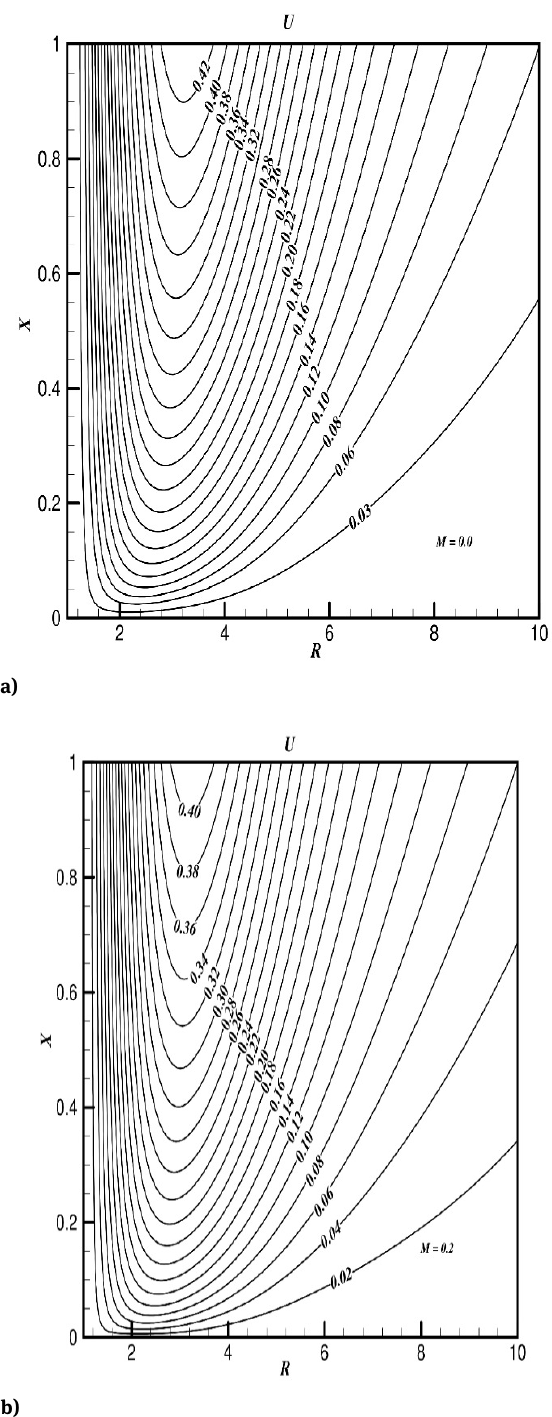
Figure 16: Steady state velocity contours ( a ) M = 0.0 ( b ) M = 0.2 for fixed Sc = 0.6 , Pr = 0.7 , Bu = 1.0 , Kr = −0.2 , Nr = 2.0 , K 1 = 1.0 , Ec = 0.1 .